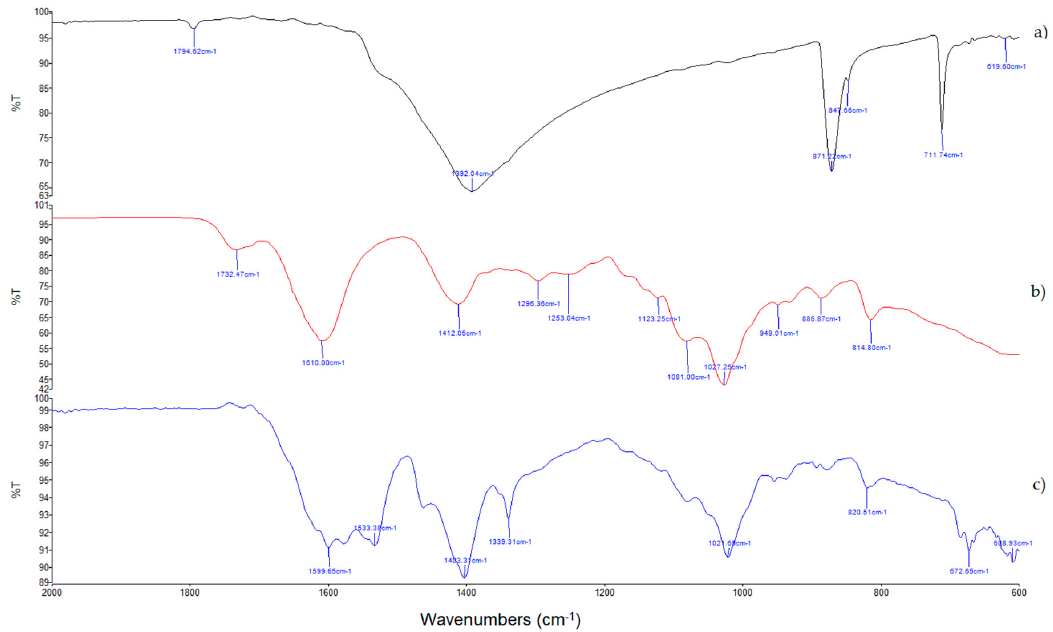
Figure 1. Fourier transform infrared spectroscopy (FTIR) spectra of CaCO 3 ( a ), non-floating blank F1 beads (F1_b) ( b ), and floating blank F4 beads (F4_b) ( c ).